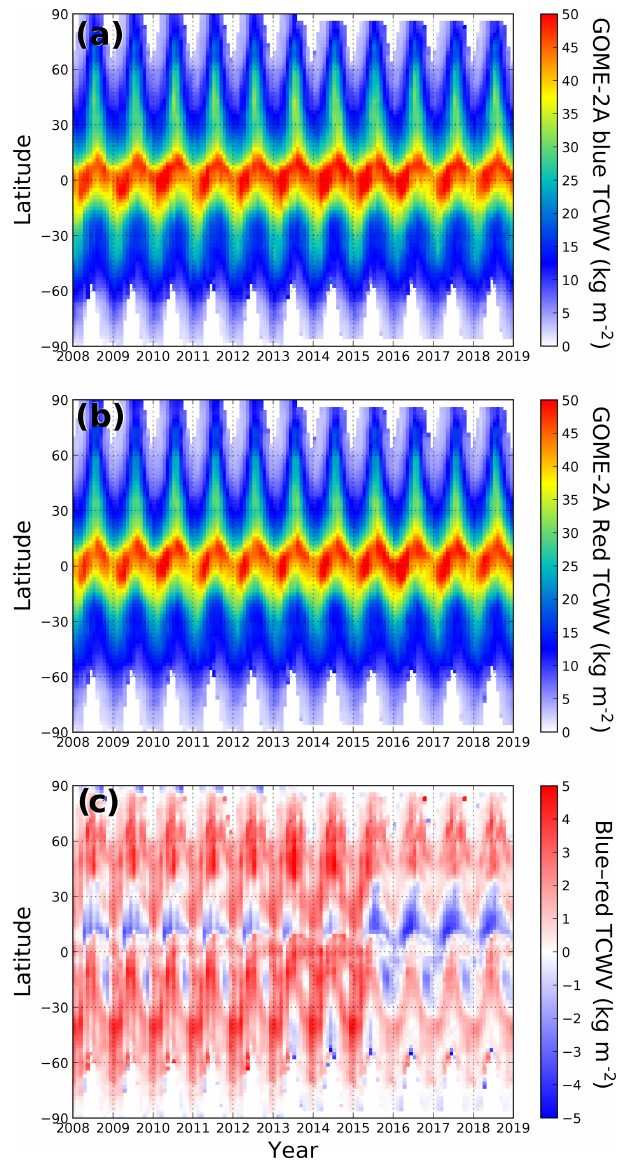
Figure 9. Monthly zonal average of TCWV from GOME-2A obser- vations in the (a) blue and (b) red spectral bands. The differences between the two data sets are shown in (c) . Data over 11 years, from 2008 to 2018, are